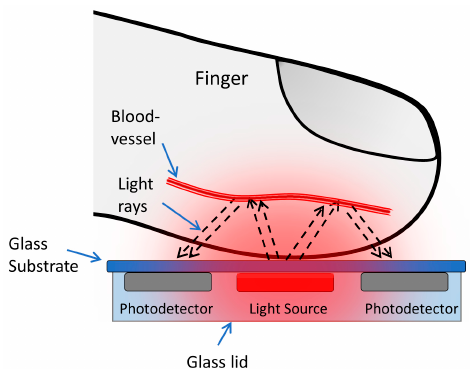
Figure 1. Acquisition of photoplethysmogram (PPG) signal from the reflection method.